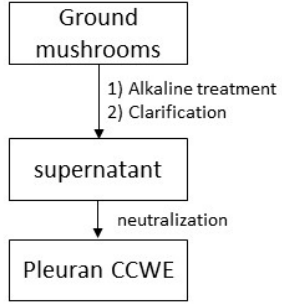
Figure 8. Pleuran CCWE extraction diagram.